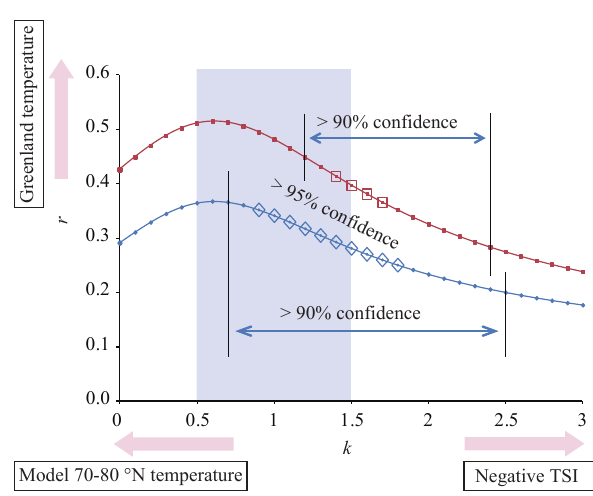
Fig. 7. Correlation coefficients between the ice-core-derived and modelled Greenland temperatures. Red and blue dots indicate cor- relation coefficients in multidecadal (21yr RMs) and centennial (101yr RMs) scale variations, respectively. Larger diamonds and rectangles are correlations with the > 95% confidence. Shaded area ( k =1 ± 0.5) shows the uncertainty range (2 σ ) of the k value. Con- sidering uncertainties in climate forcings, at least 14% ( r =0.36) and 20% ( r =0.45) of the variances of the ice-core-derived Green- land temperature on multidecadal to centennial scales, respectively, can be explained by the model. Red arrows indicate that higher cor- relations exhibit more similarity to the observed Greenland temper- ature, and smaller (larger) k values are more similar to the modelled 70–80 ◦ N temperatures (negative TSI),